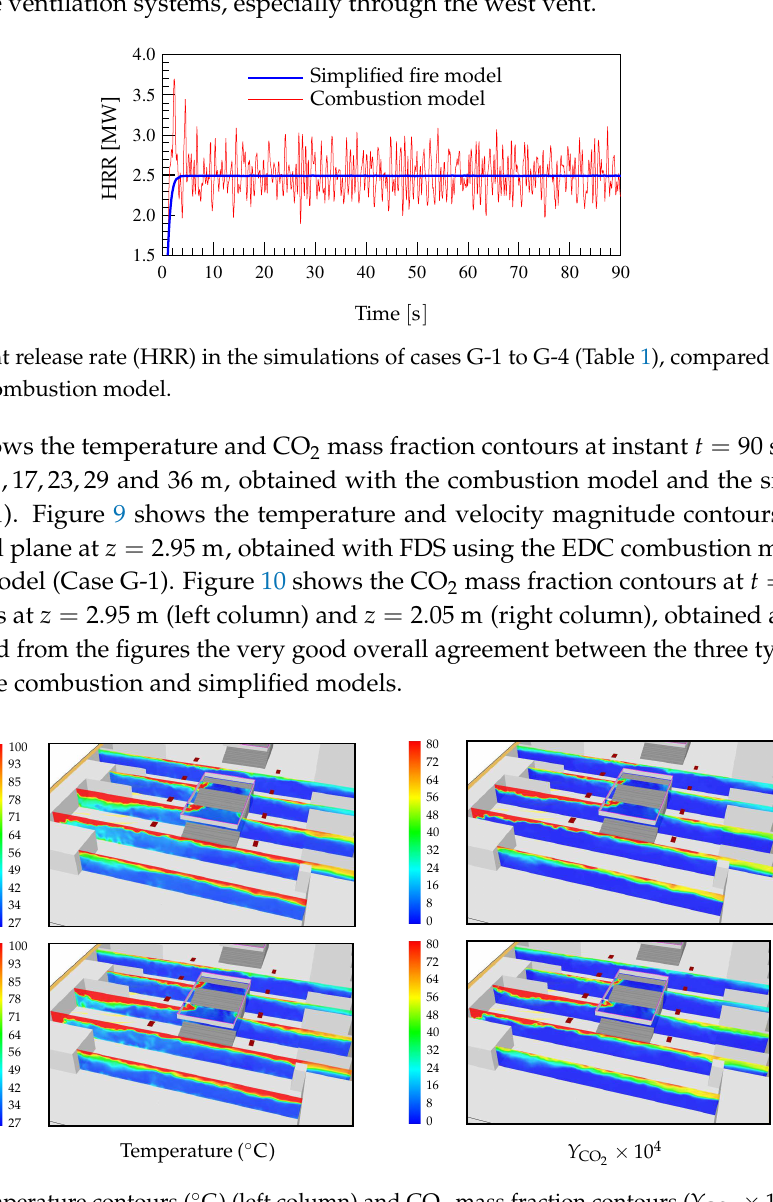
Figure 8. Temperature contours ( ◦ C) (left column) and CO 2 mass fraction contours ( Y CO column) at instant t = 90 s and x = 11, 17, 23,29 and 36 m, obtained with FDS using a grid with L / δ 10. ( a ) Combustion model with RADIATIVE FRACTION = 0 and ( b ) simplified fire model with T in = 2436 K (Case G-1).